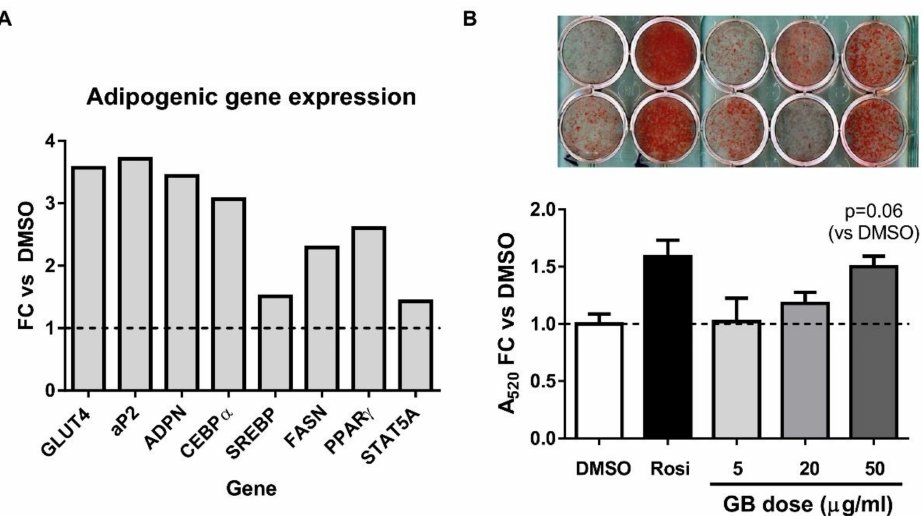
Figure 1. Groundsel bush promotes lipid accumulation and adipocyte marker gene expression in 3T3-L1 cells. ( A ) Six days after 3T3-L1 preadipocytes were induced to differentiate using the standard induction cocktail in the presence or absence of 50 µ g/mL of groundsel bush, RNA was isolated, purified, and subjected to RT-qPCR; ( B ) In a separate experiment, 3T3-L1 preadipocytes were induced to differentiate using half-strength induction cocktail containing 5, 20 or 50 µ g/mL of groundsel bush (GB). Six days post-induction, cells were fixed and then stained with Oil Red O (photograph in top panel; all of the wells were from the same 12-well plate, and brightness and contrast were equally adjusted for all wells). Staining was quantified by measuring absorbance at 520 nm after extraction of stain in isopropyl alcohol (bottom panel; n = 2 wells per treatment). Fold change (FC) was calculated by normalizing the data against the DMSO (dimethyl sulfoxide) vehicle control. Rosiglitazone (Rosi) was used as a positive control in ( B ). Results shown are from duplicate cell culture wells, and the experiment was repeated two additional times on independent batches of 3T3-L1